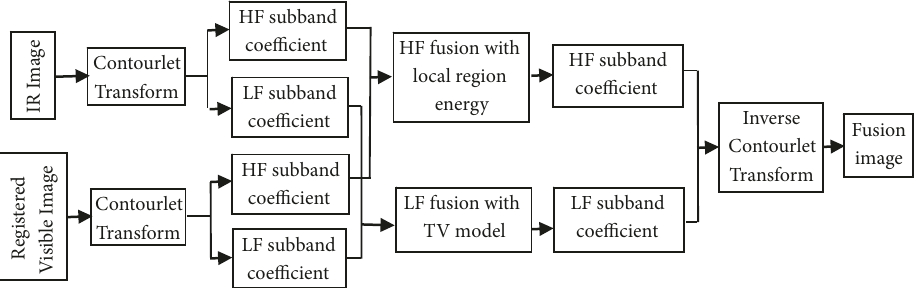
Figure 8: Flow chart of image fusion